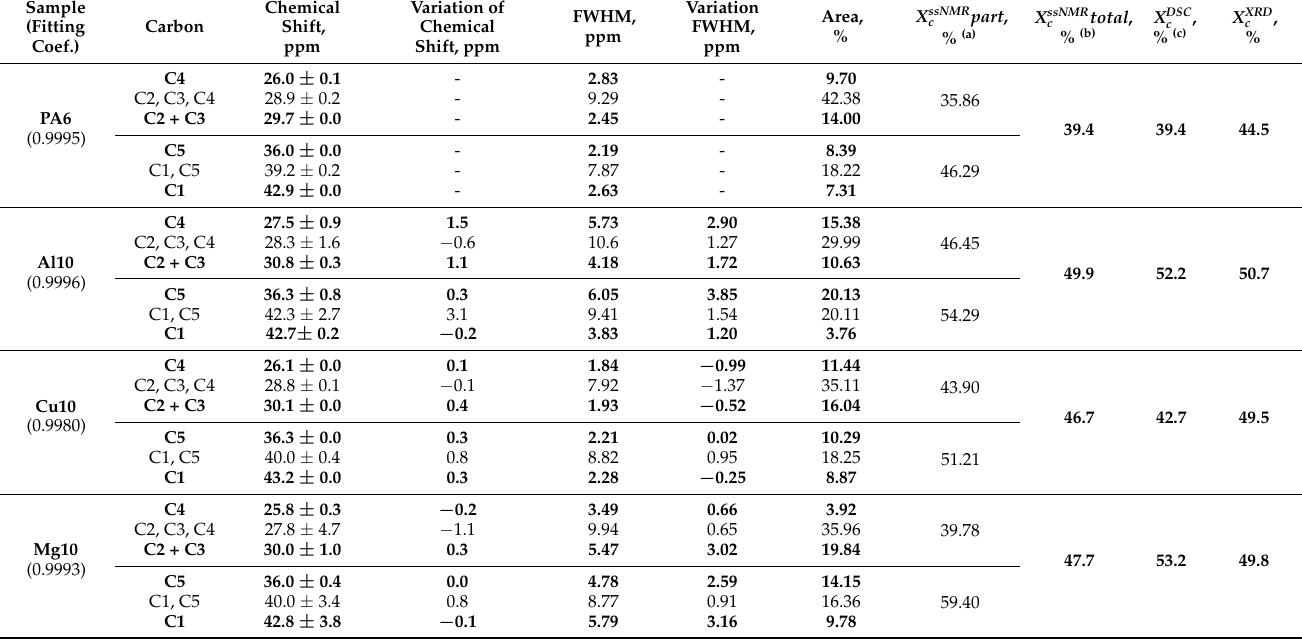
Table 4. 13 C CP/MAS results for the aliphatic region. The carbons in boldface are those of the crystalline PA6